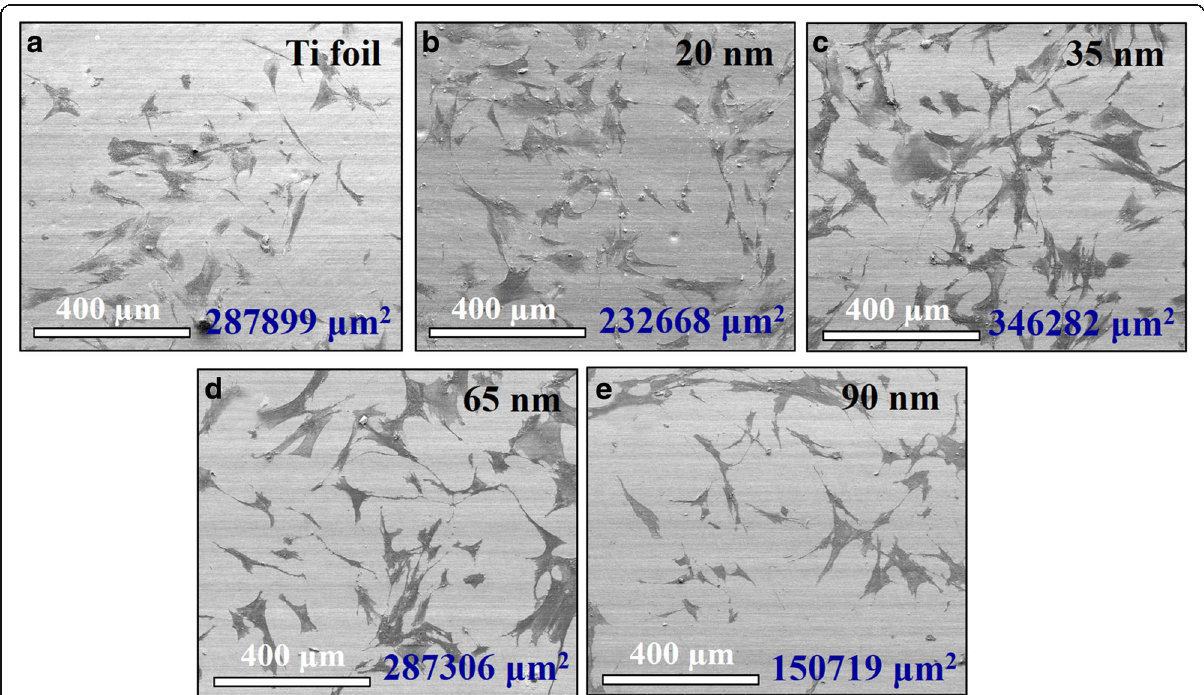
Fig. 7 a – e SEM images showing the cell adhesion and proliferation of human fibroblast cells on the a Ta foil surface and self-organized TaO x nanotubes with diameters of b 20, c 35, d 65, and e 90 nm, respectively. The coverage areas of cells on the samples estimated by ImageJ software are denoted in the images